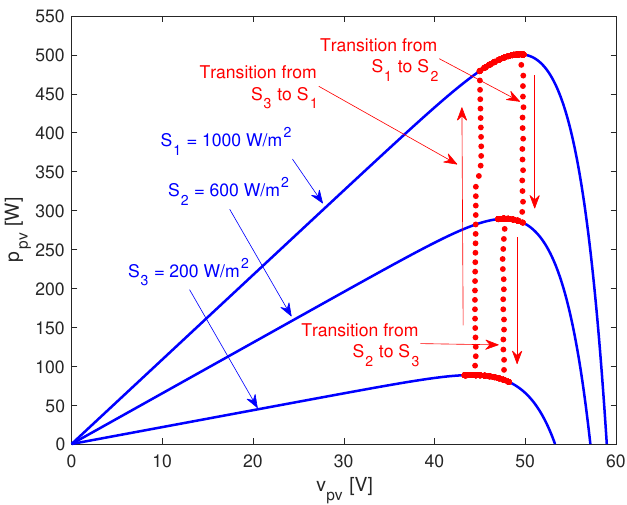
Figure 18. Maximum power point tracking